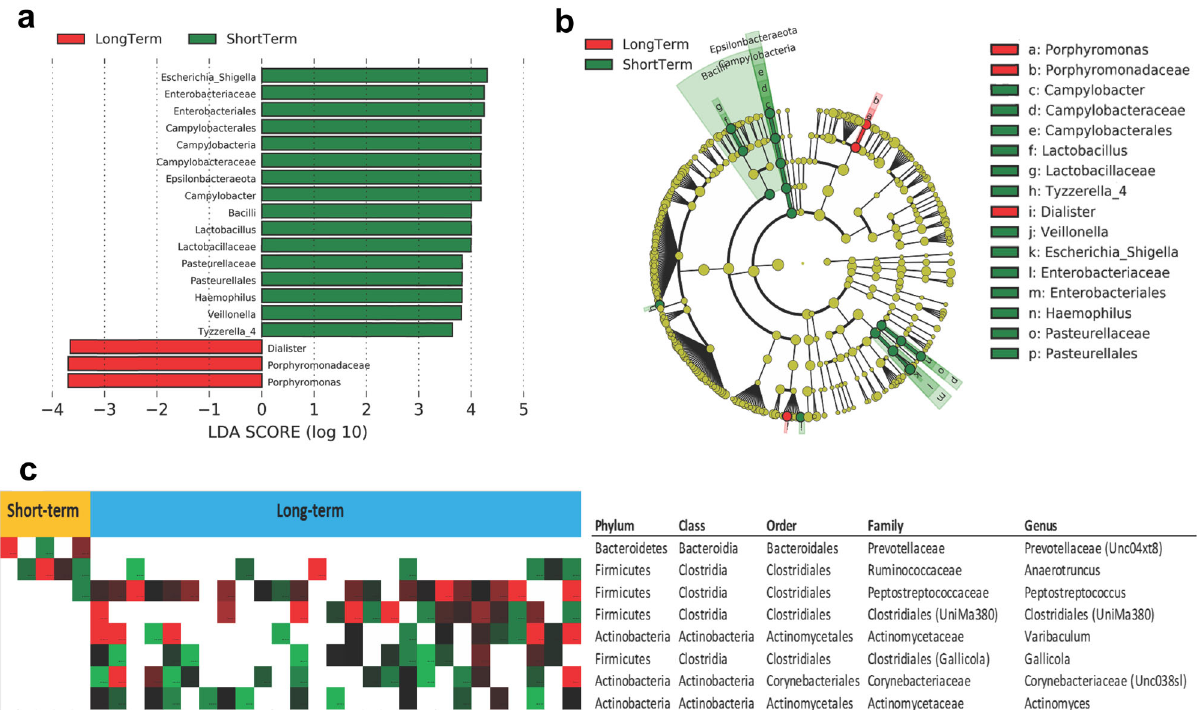
Fig. 2 Compositional differences of the gut microbiome in short and long-term survivors. a The different abundance of bacterial taxa between the two groups were identi fi ed by LEfSe. It was signi fi cantly different when alpha value of the factorial Kruskal – Wallis test was <0.05 and the logarithmic LDA score was >3.5. The left histogram showed the LDA scores of taxa differentially abundant between the two groups. The taxonomy was listed, followed by its core group. Putative species (Speci fi c OTUs) identi fi ed as signi fi cantly more enriched/depleted (Fisher/Wilcoxon test p value<0.05) in patients with short-term vs long- term in baseline samples. b Cladogram representation of the signi fi cantly different taxa features from phylum (inner circle) to genus (outer circle). c The